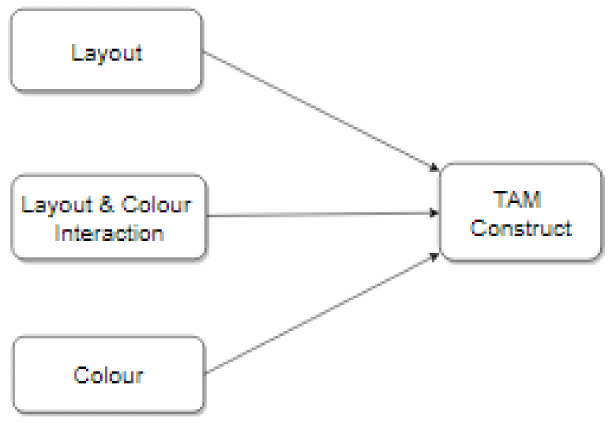
Figure 2. Research